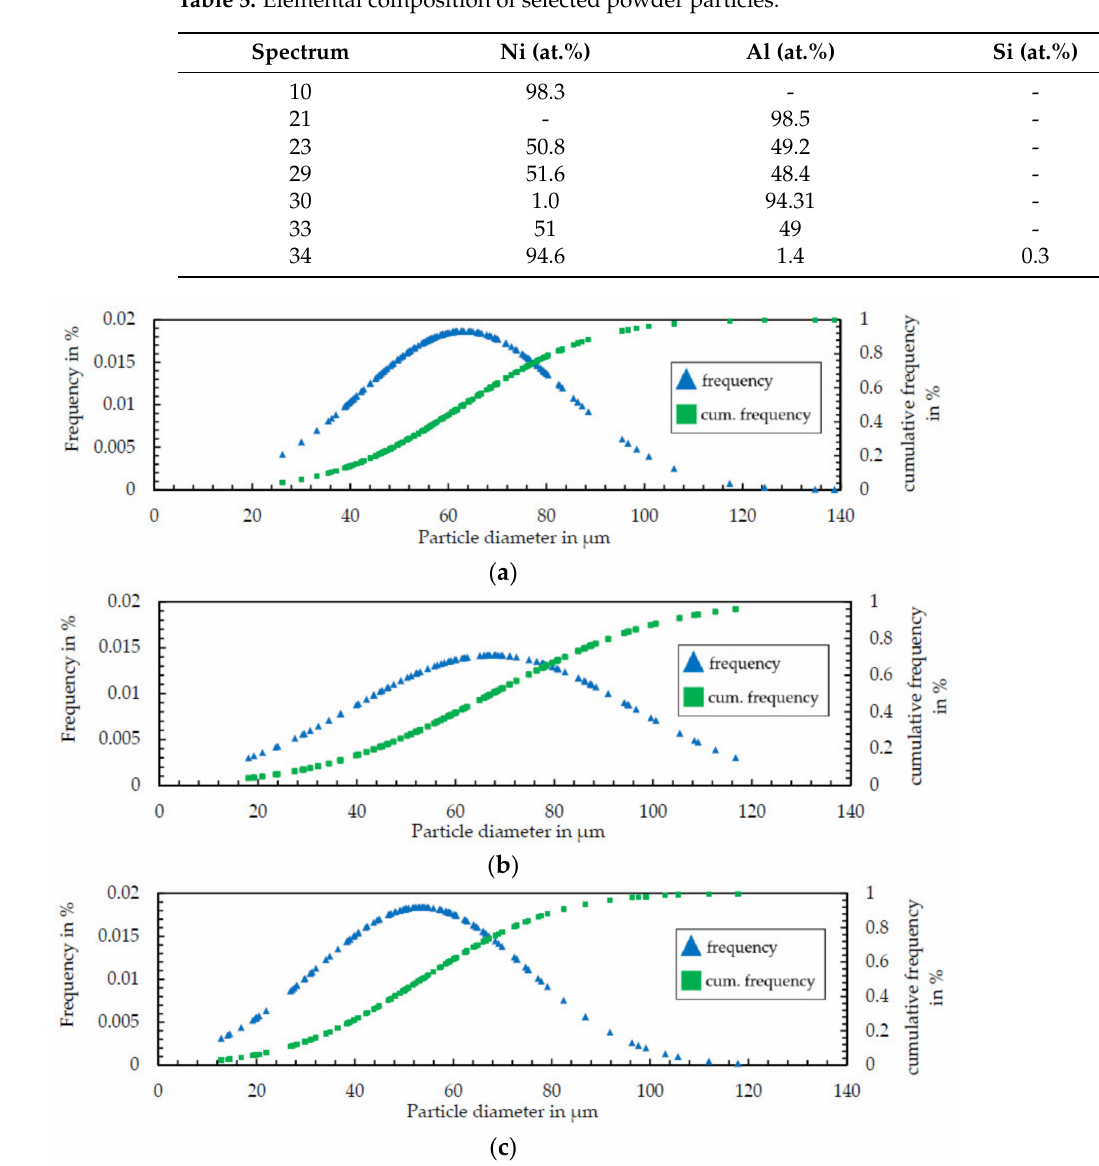
Figure 6. Particle size distribution of the used Ni50Al50 powder ( a ), Al powder ( b ) and Ni-alloy 201 powder ( c ) determined by image